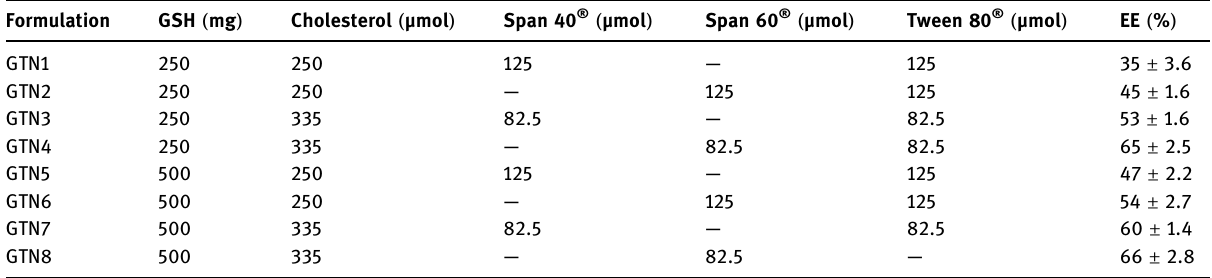
Table 1: Composition of glutathione - loaded niosomes prepared with 1:1 and 2:1 molar ratios of cholesterol and non - ionic surfactant mixture ( Span 40 ® and span 60 ® : Tween 80 ® )